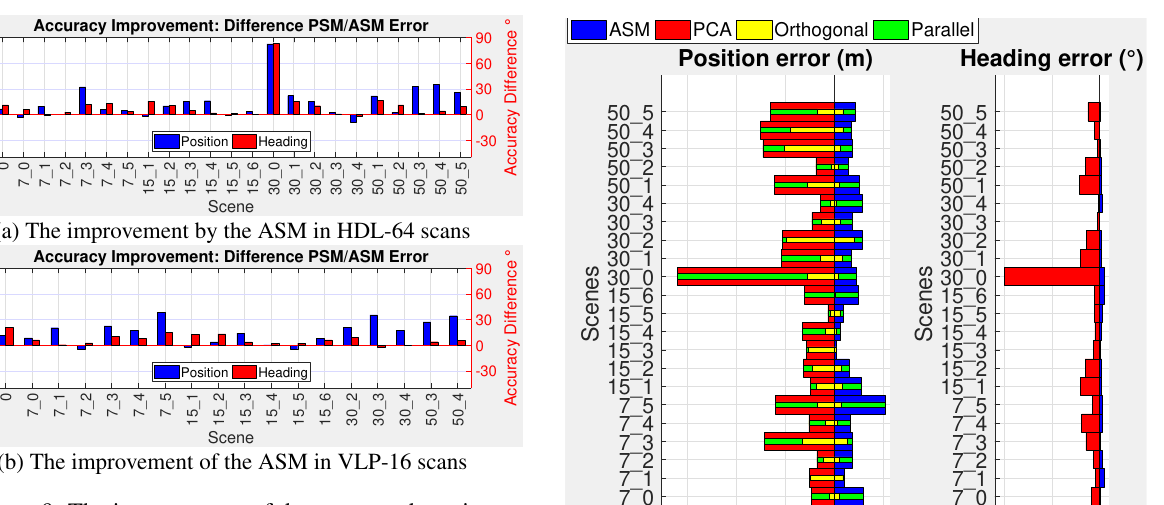
Figure 9. The improvement of the accuracy by using ASMs in contrast to the BC-PCA for the van